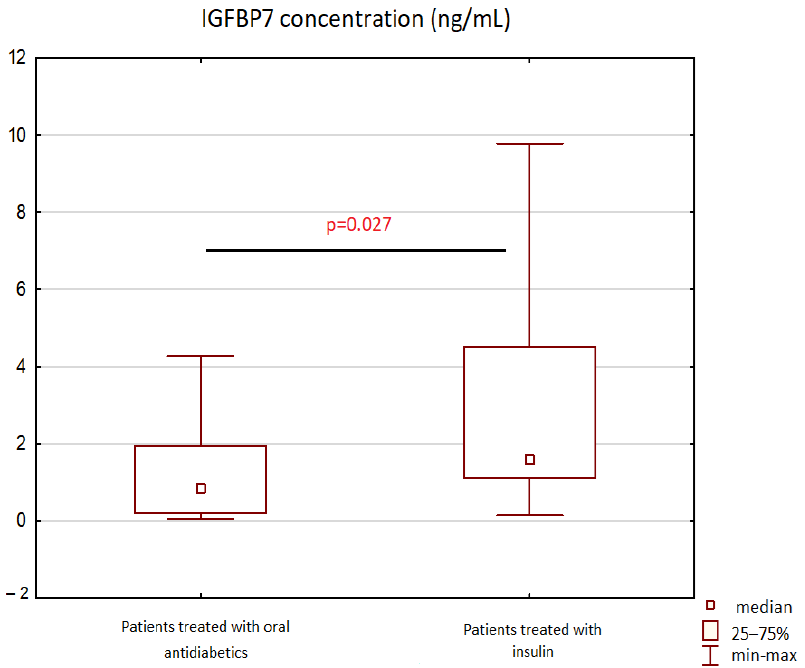
Figure 3. IGFBP-7 concentration in patients on insulin therapy vs. patients treated with oral antidi- abetics. Abbreviations: IGFBP-7—insulin-like growth-factor-binding protein 7. betics. Abbreviations: IGFBP-7—insulin-like growth-factor-binding protein